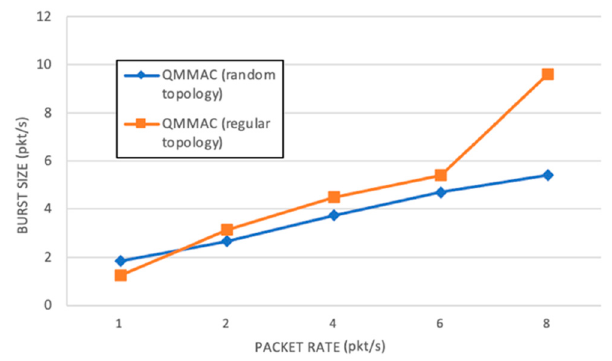
Figure 13. Burst Figure 13. Burst size.